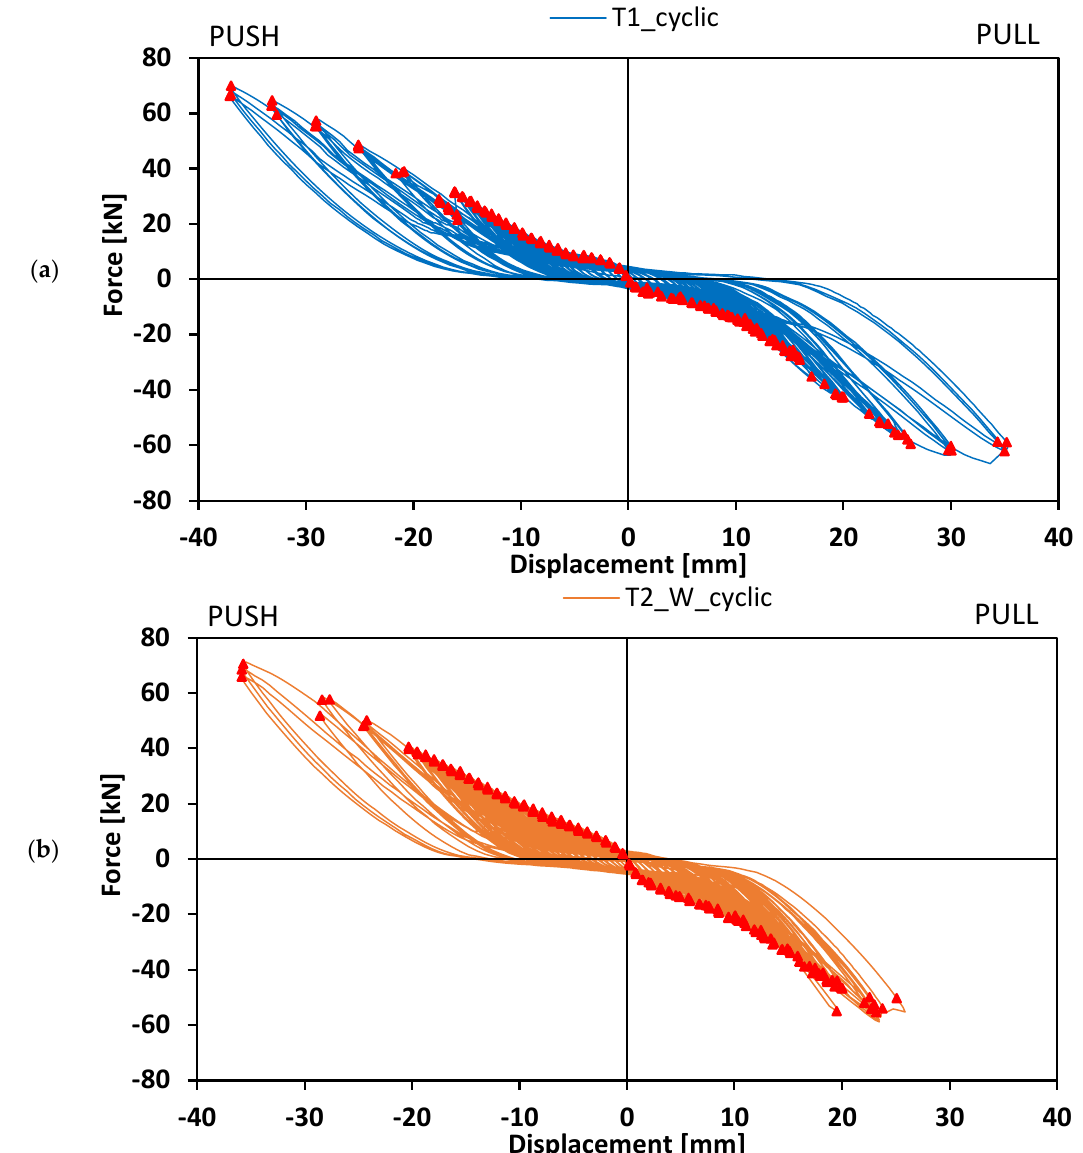
Figure 8. Load–displacement hysteresis curves concerning beam-to-column elements: ( a ) specimen T1; ( b ) specimen T2_W.